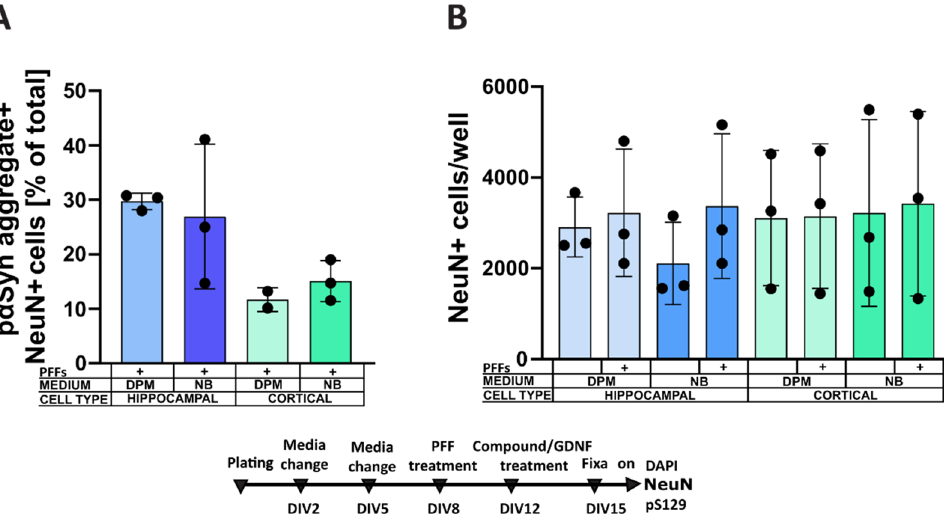
Figure 6. The effect of different culturing media (DPM, NB) on α -syn aggregation in primary mouse embryonic hippocampal (HIP) and cortical (CORT) neurons. ( A ) The effect of the media on the formation of intracellular LB-like inclusion in hippocampal and cortical neurons. ( B ) Number of NeuN-positive cells per well in correspondent media in hippocampal and cortical cultures. n = 3 independent experiments, data are mean ± SD.